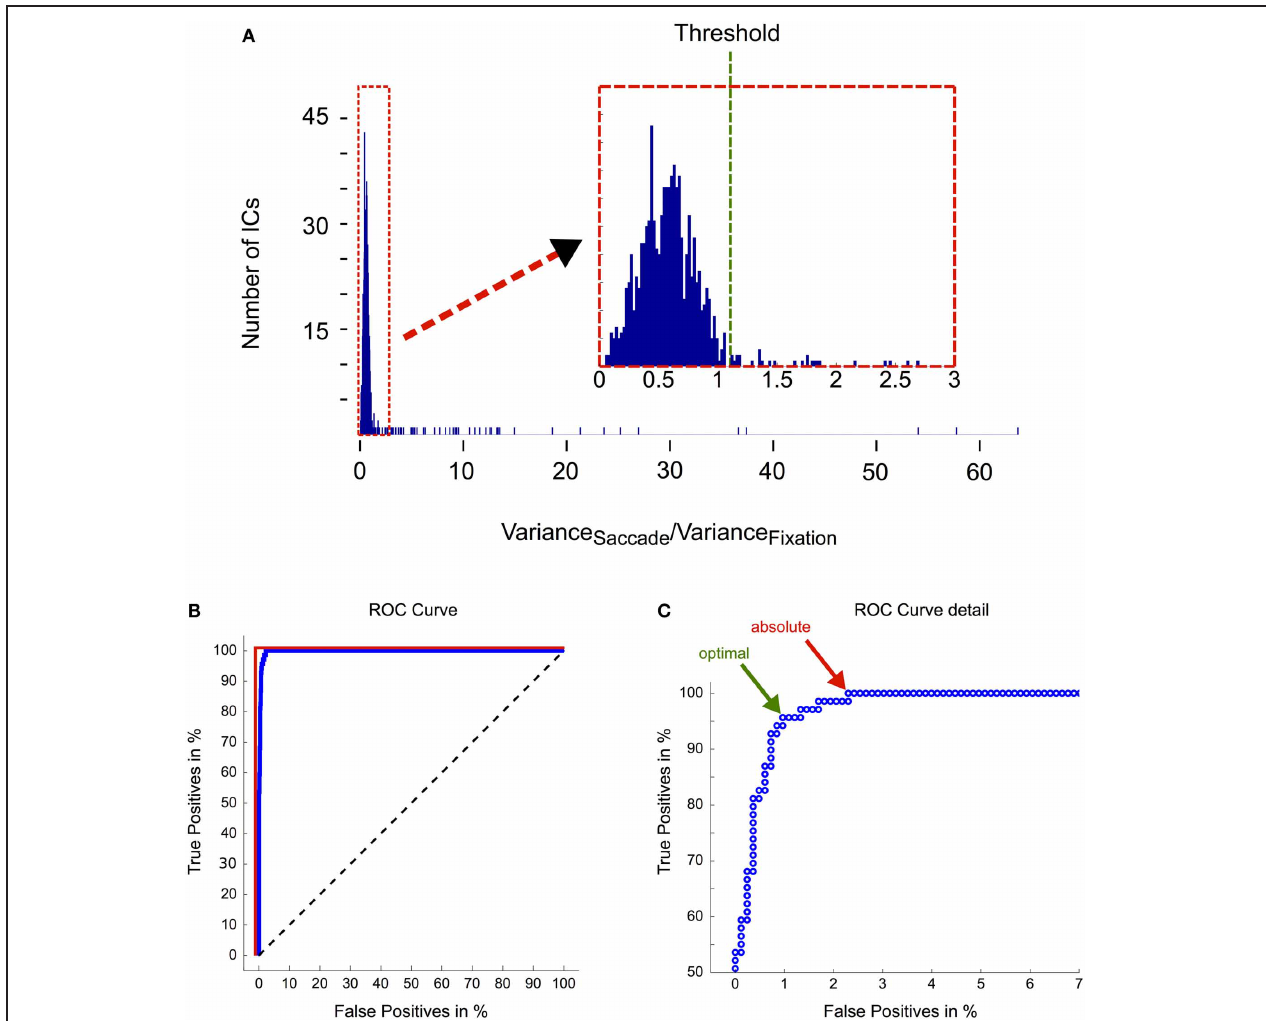
FIGURE 8 | Evaluation of the IC selection procedure. (A) Distribution of saccade/fixation variance ratios. The magnification in the inset illustrates that the ratios are not clearly bimodally distributed. Therefore the threshold that optimally separates eye movement-related ICs from non-ocular ICs is difficult to determine. Based on heuristics, that is after inspecting IC activations that had a ratio above one and that we considered likely to be eye movement-related, we set the threshold to a ratio of 1.1. (B) ROC analysis. ROC curves are graphical illustrations of how well two different classes (here: eye movement-related ICs vs. non-eye movement-related ICs) can be separated depending on the threshold of the discrimination criterion (here: the ratio between the variance in saccade and fixation intervals). Each point on the blue curve represents the saccade/fixation variance ratio of one IC starting with the highest (63.71) in the lower left corner and ending with the lowest (0.04) in the upper right corner. If ICs could be unequivocally separated into being eye- or non-eye-related solely based on their variance ratio, lowering the threshold would include more and more eye movement ICs (as determined by expert tagging) until a true positive rate of 100% is